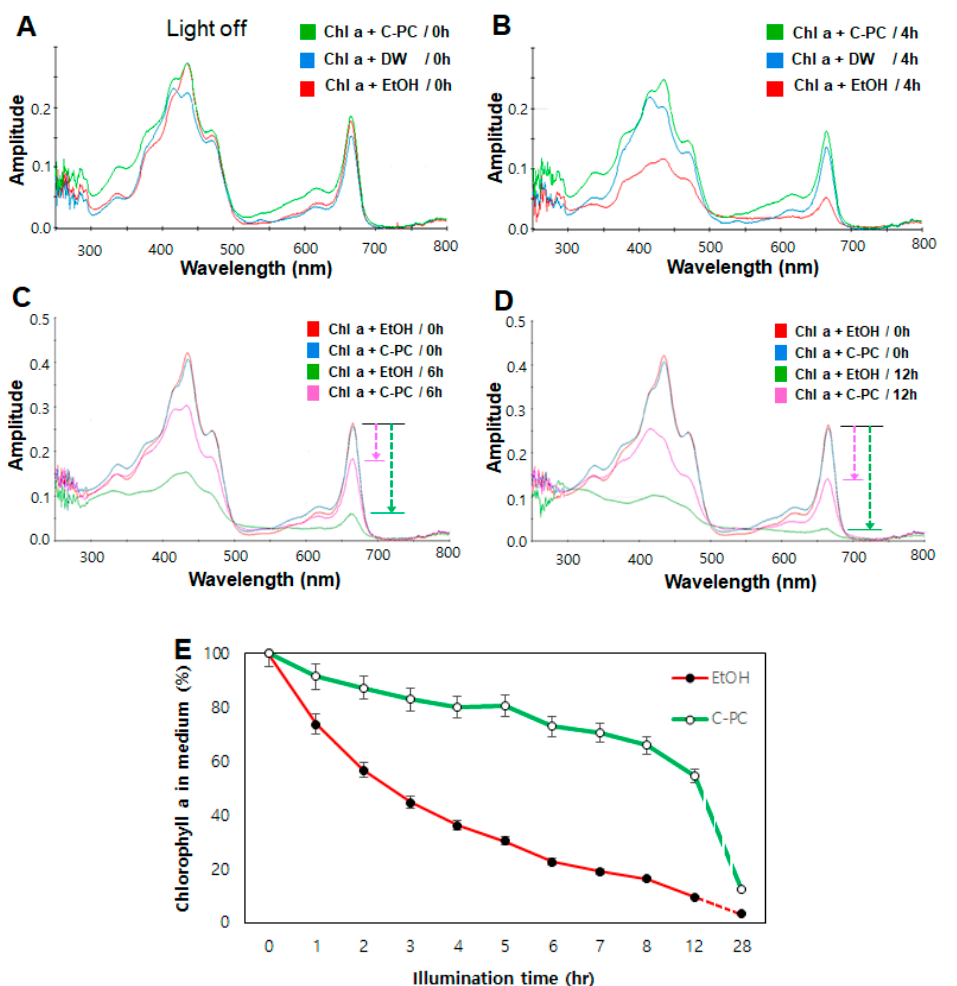
Figure 1. UV/VIS absorption spectra of chlorophyll a in ethanol (EtOH), deionized water (DW), and C-phycocyanin (C-PC) media. ( A ) Before light treatment. ( B ) After 4 h of intense white light illumination (100 µmol ∙ m − 2 ∙ s − 1 ). The initial chlorophyll extracts added to EtOH, DW, or C-PC medium were prepared as described earlier. ( C ) UV/VIS absorption spectra of chlorophyll a in high C-PC solution (600 ppm) was compared after 6 h of illumination. ( D ) After 12 h of illumination (100 µmol ∙ m − 2 ∙ s − 1 ). ( E ) Chlorophyll content in EtOH and C-PC solution per hour during illumination for 28 h. The values are expressed as means ± standard deviation ( n = 3).